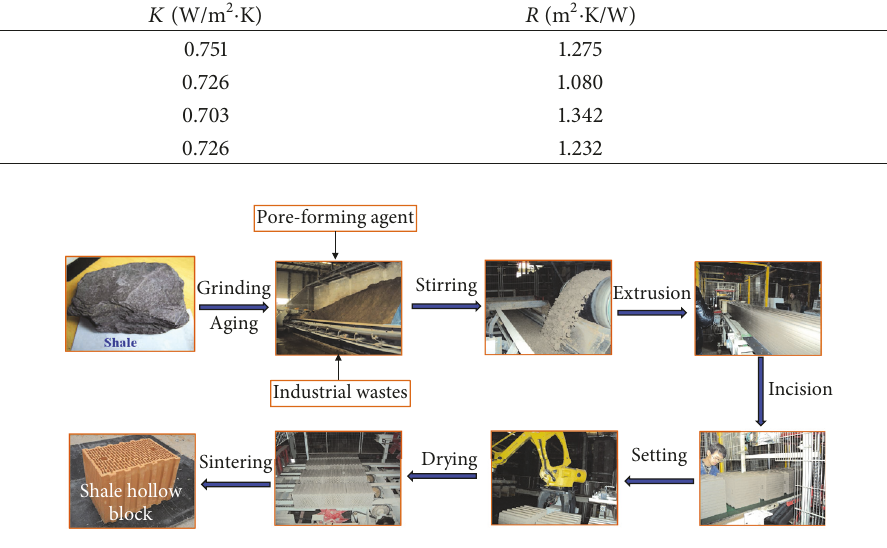
Figure 3: Production procedure for hollow shale blocks.